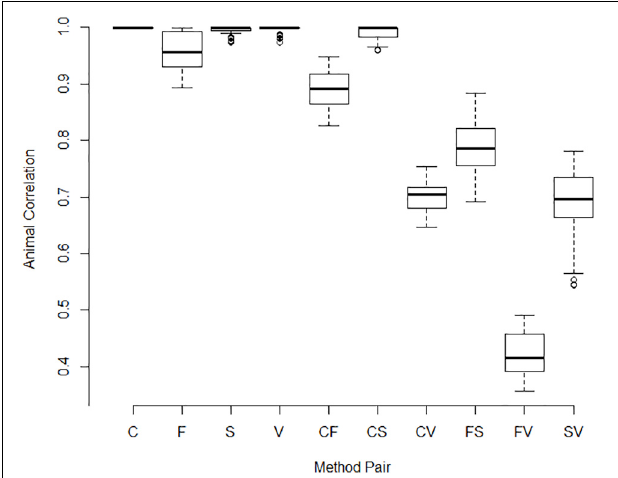
FIGURE 2 | Correlations between pools for animal contributions by method of pooling. The correlation between animal contributions to 2 pools was estimated using bivariate analysis with starting values set to the result of a univariate analysis. Methods include equal volume of blood diluted to constant white blood cell count (C), equal DNA by spectrofluorometry (F), equal DNA by spectrophotometry (S), and equal volume of whole blood (V). Single letter codes designate correlations between pools within method whereas two letter codes signify correlations between pools constructed by different methods. Correlations among animal contributions within method were near 1 and were lower between pools of different methods. Pools constructed based on separate measurements within pool or replicated pool constructions and or extractions were highly correlated as evidenced by the small interquartile